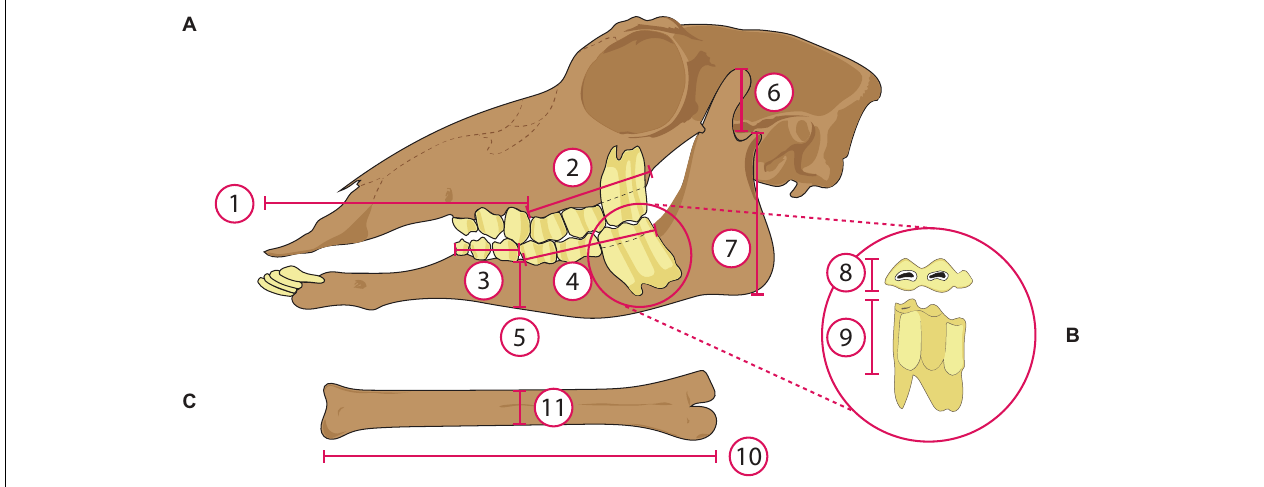
FIGURE 3 | Measurements taken from osteological material of extant and extinct artiodactyls. (A) Lateral view of the skull, (1) length of anterior portion of skull; (2) length of upper molar row (measured along the alveolar row); (3) length of lower premolar row (measured along the alveolar row); (4) length of lower molar row; (5) depth of the jaw corpus, taken at the boundary of the molar and premolar row; (6) moment arm of temporalis; (7) moment arm of masseter. (B) Occlusal (above) and labial (below) view of a lower third molar, (8) occlusal width of the m3, (9) crown height of the m3. (C) Metatarsal, (10) length of the metatarsal, (11) width of the metatarsal. Not to scale. Skull of the antilocaprid Plioceros modified from Frick (1937).